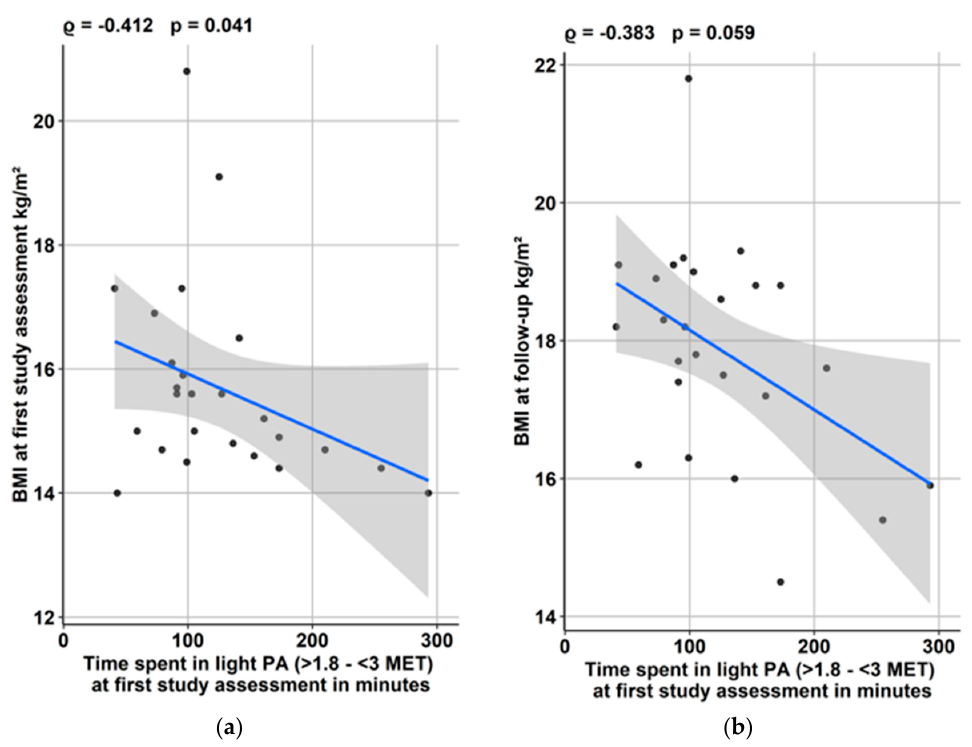
Figure 2. Impact of time spent in light physical activity (PA) at first study assessment ( a ) on admission BMI and ( b ) BMI at outpatient follow-up .